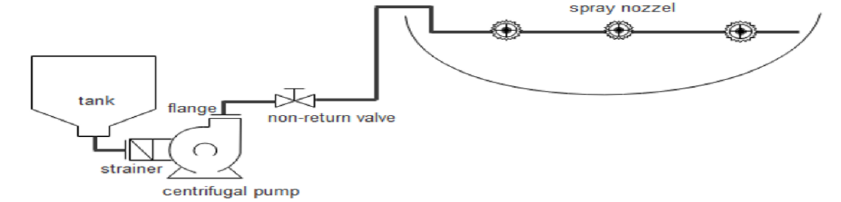
Figure 3. Mechanical diagram of the system.